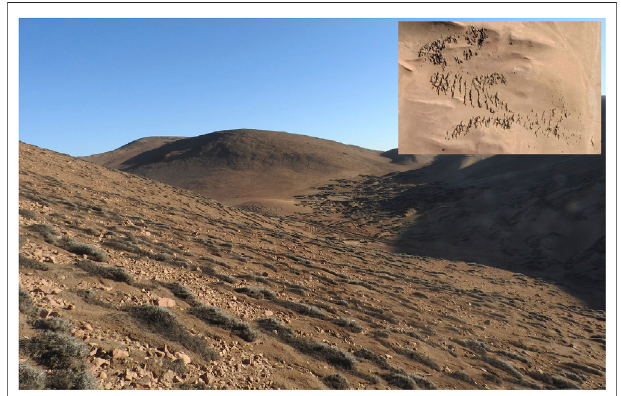
FIGURE 10 | Plant ( Tillandsia sp.) banding growth patterns on top of Coastal Range hills. The inset shows how these plants look from space.